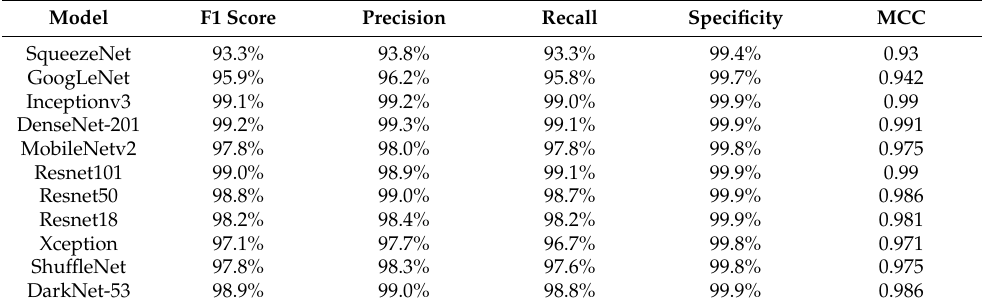
Table 3. The mean overall F1 score, Precision, Recall, Specificity, and MCC using 90% of the data for training. The results are an average of 10